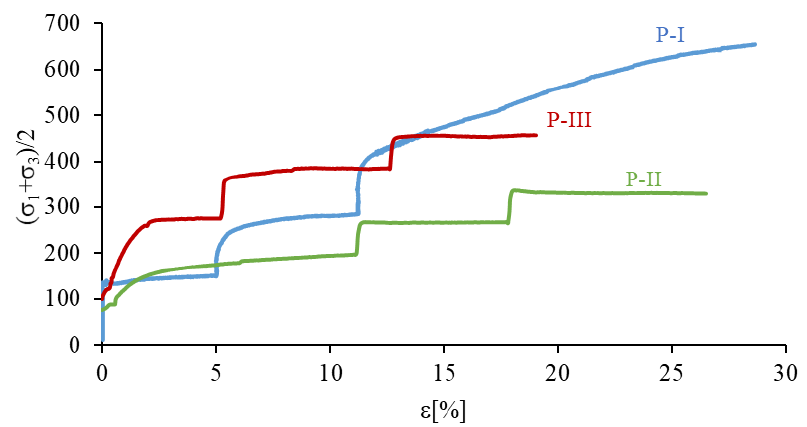
Figure 10. The comparison of shear strength results for analysed soils.